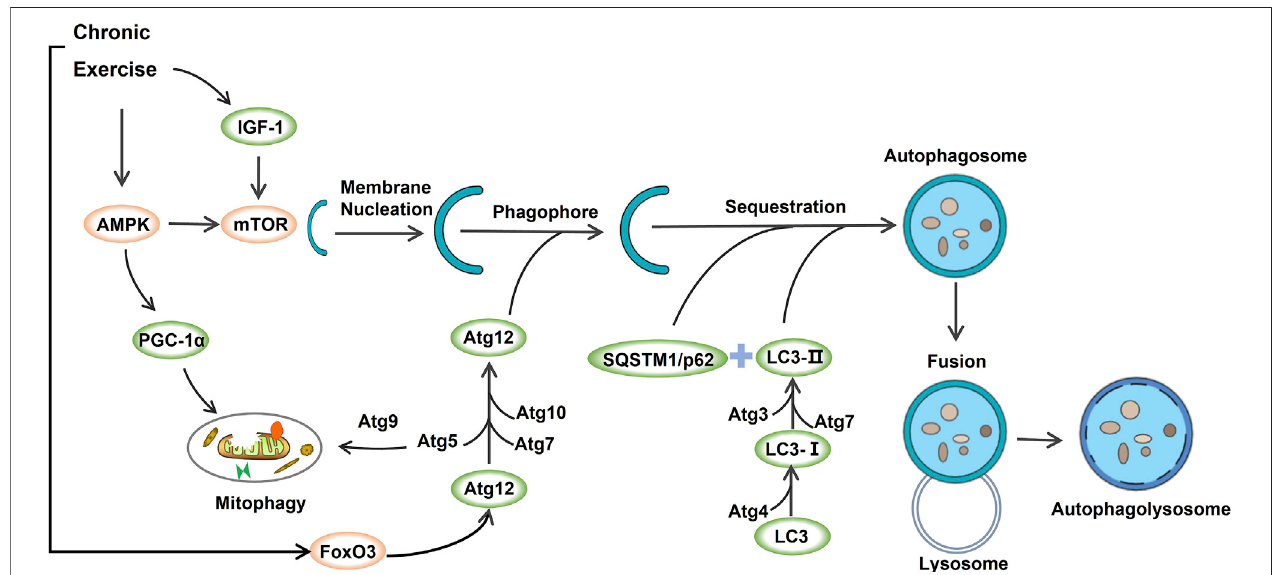
FIGURE 2 | The underlying mechanisms of exercise-induced autophagy in aging-induced skeletal muscle atrophy.